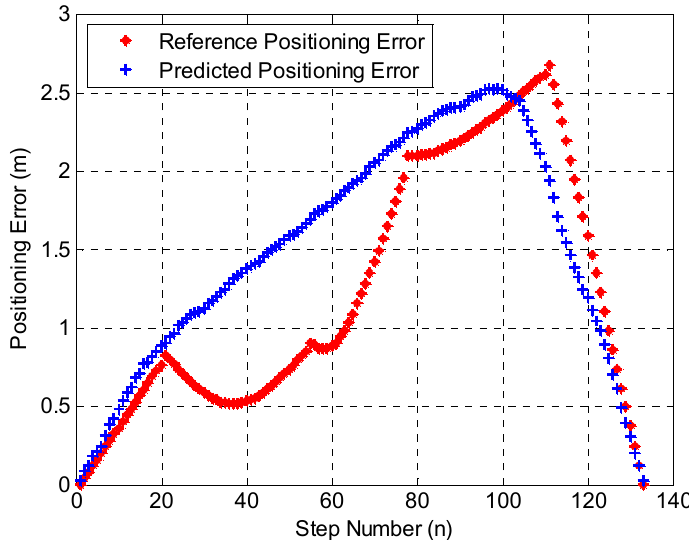
Figure 8. Performance of Error Prediction.